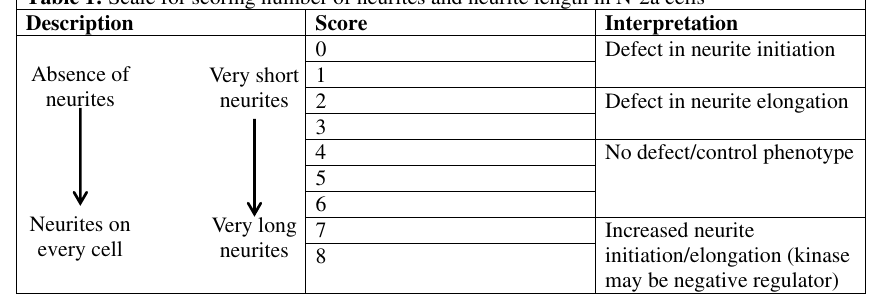
Table 1. Scale used by three blind observers for scoring number of neurites from soma and neurite length in N-2a cells. The average score for each condition was calculated and used to determine if each kinase inhibitor had an effect on the extent of neurite initiation or elongation.